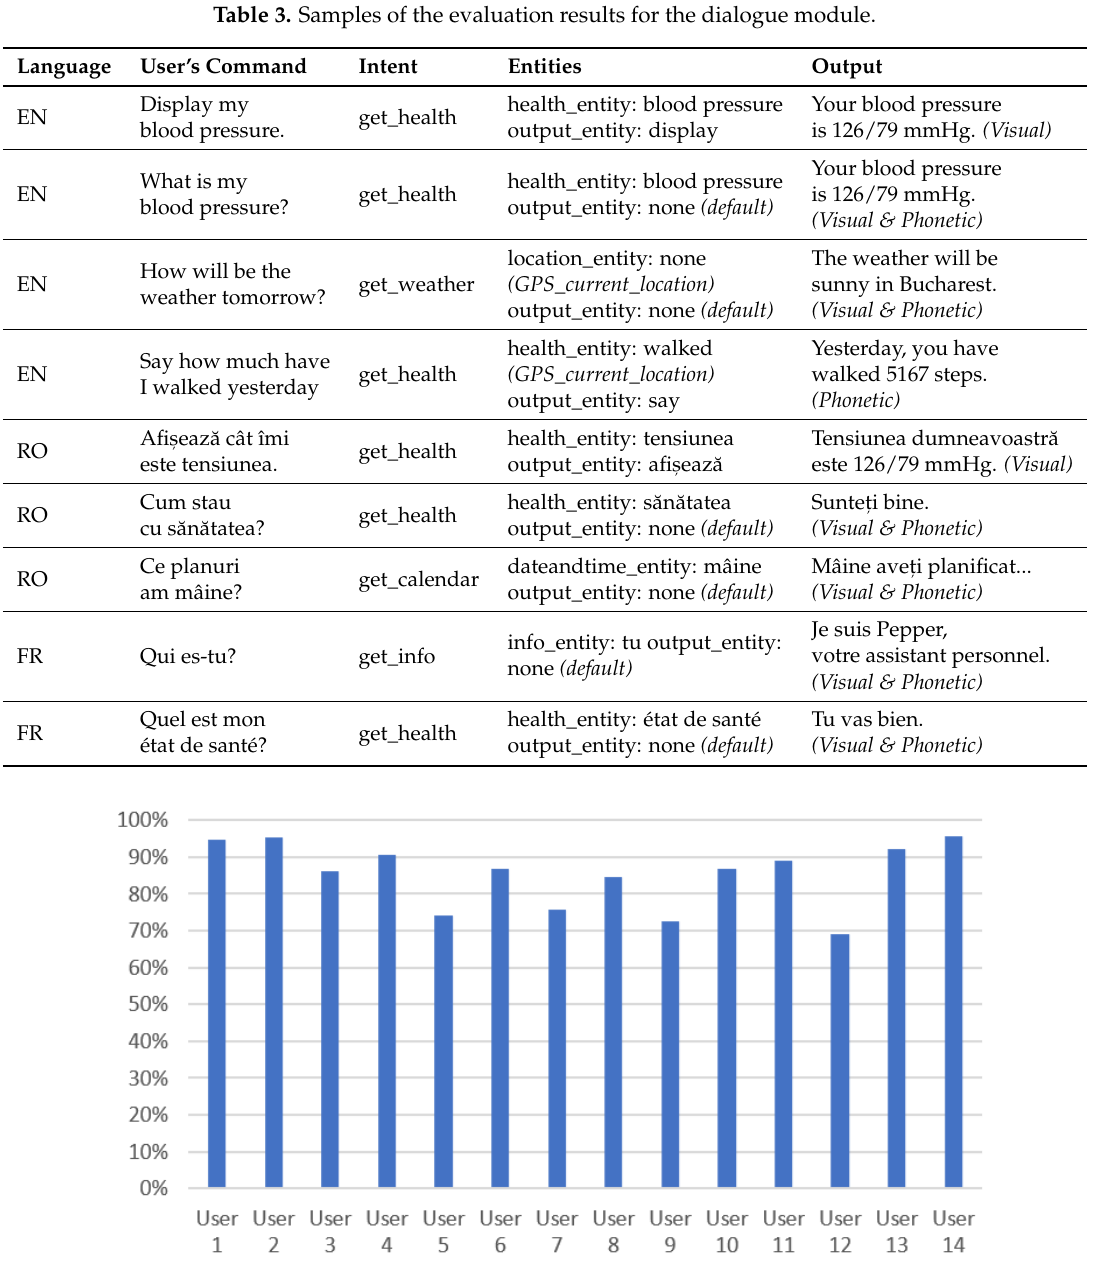
Figure 8. ASR Recognition percentage for each user—English